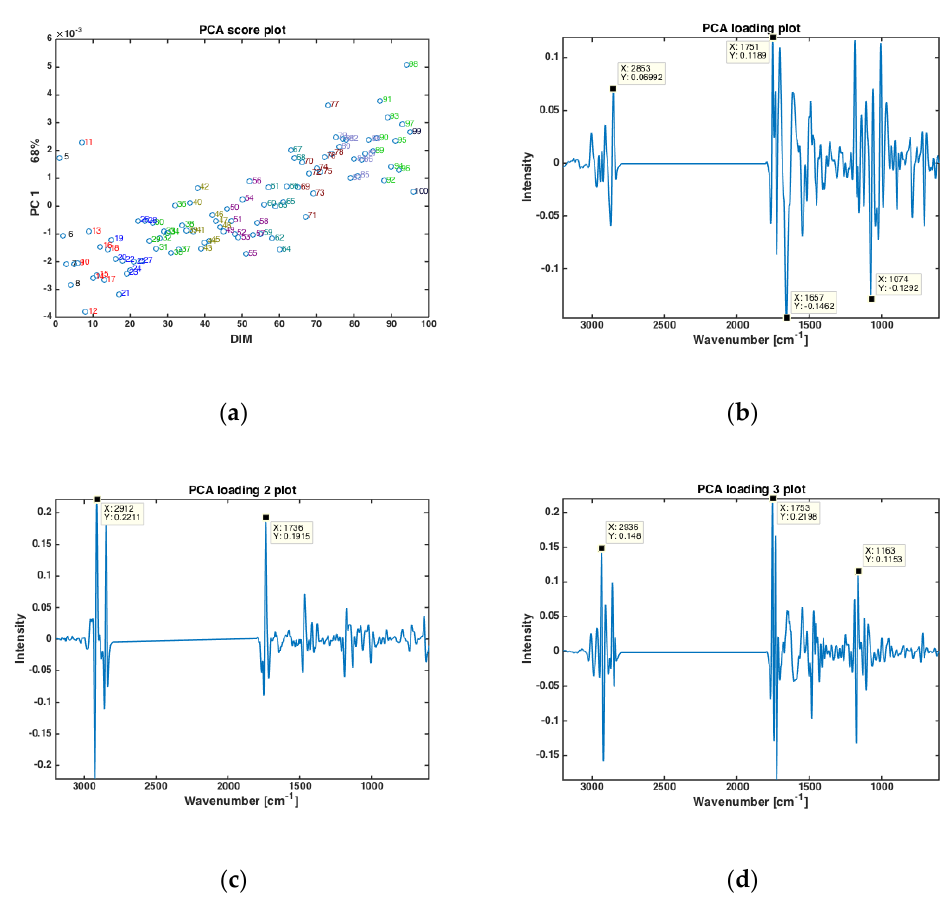
Figure 1. PCA of all FTIR spectra of milk samples averaged at a given DIM ( a ) Score plotted against DIM, and loading plots of ( b ) PC 1, ( c ) PC2 and ( d ) PC3.